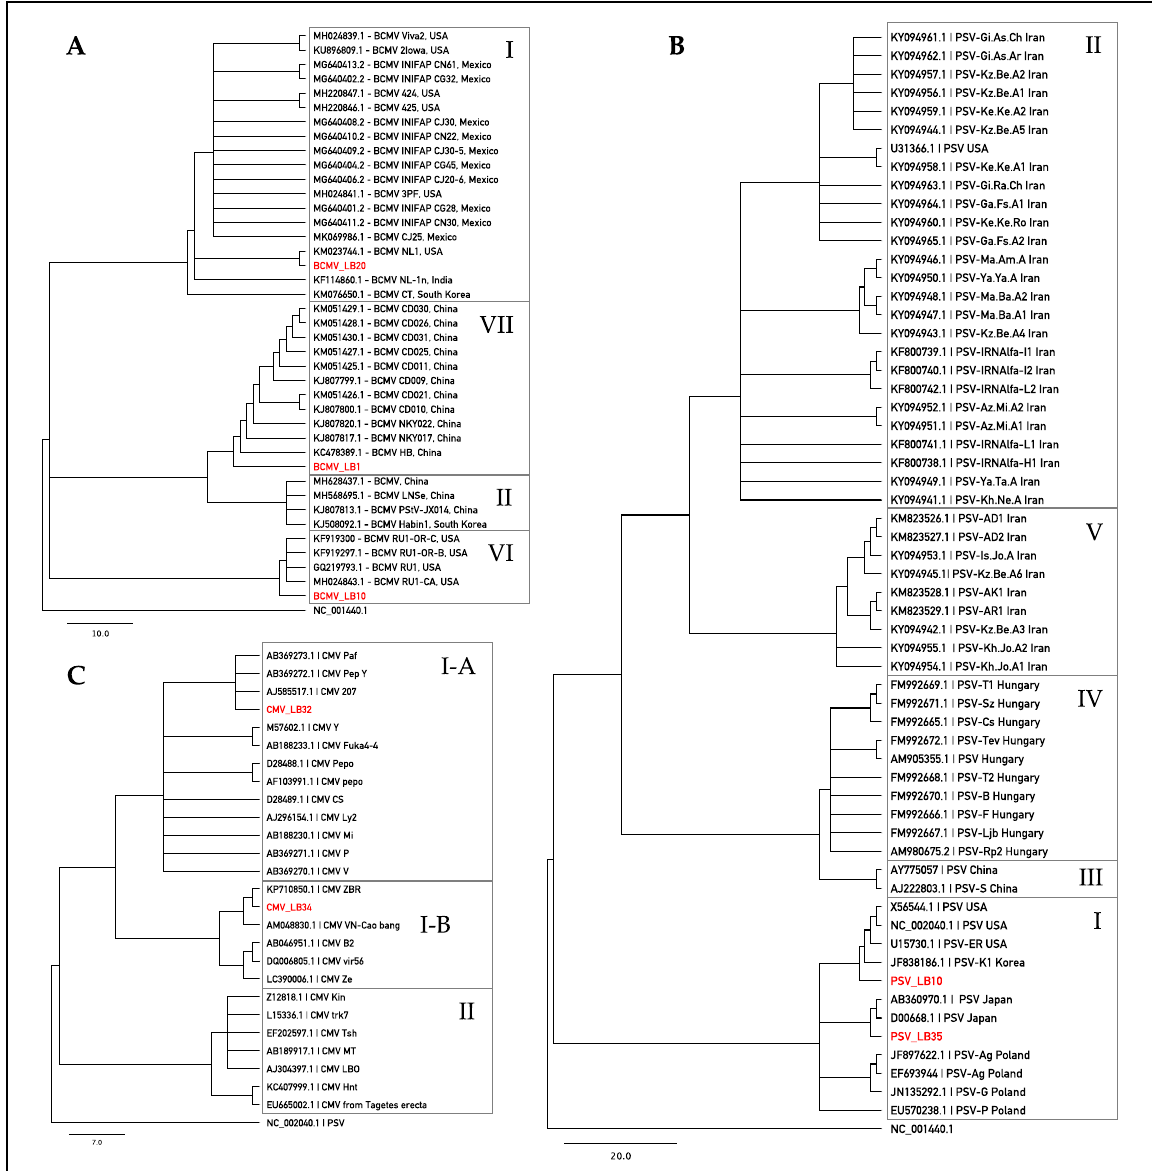
Figure 3. Phylogenetic trees of BCMV ( A ), CMV ( B ) and PSV ( C ) isolates infecting Lamon bean. Trees were constructed by the Maximum-Likelyhood (ML) method implemented in Geneious R-10 software (Biomatters Ltd.). Branch support was computed using the bootstrap method based on 500 replicates. Cucumber mosaic virus (CMV, NC_001440.1) was used as outgroup for BCMV and PSV viruses, while peanut stunt virus (PSV, NC_002040.1) was used as outgroup for CMV